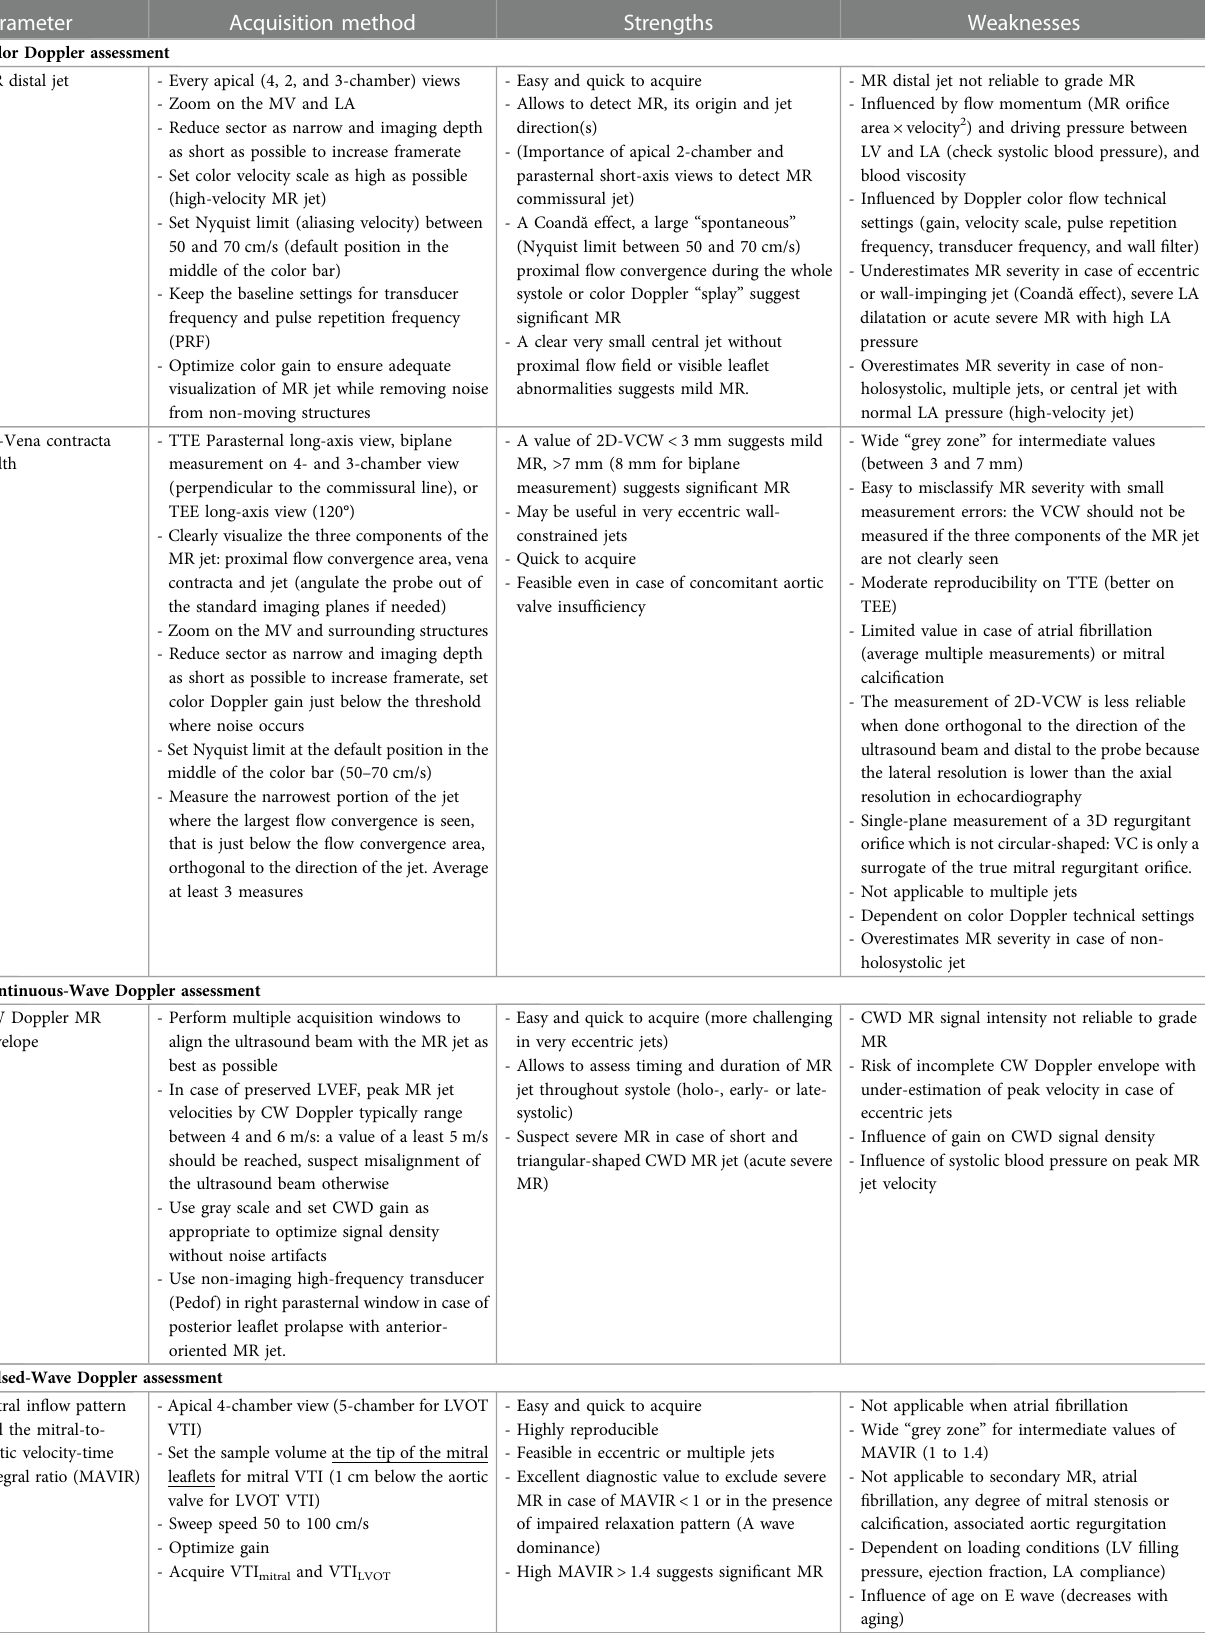
TABLE 1 Doppler-based echocardiographic parameters used for MR severity